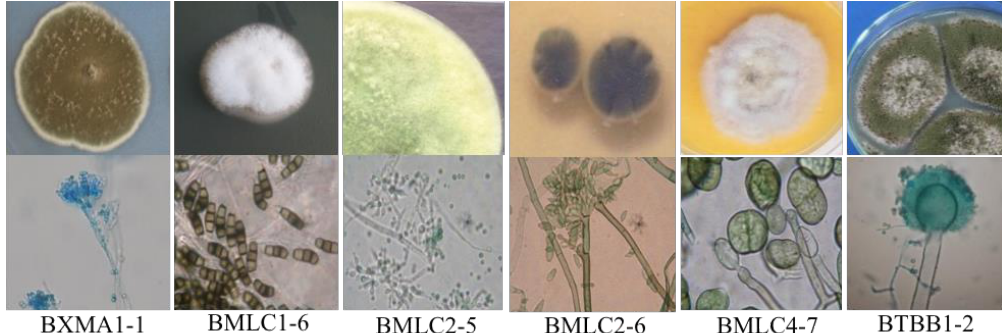
Figure 2. The colony and morphological characteristics of some fungi isolated from binocular